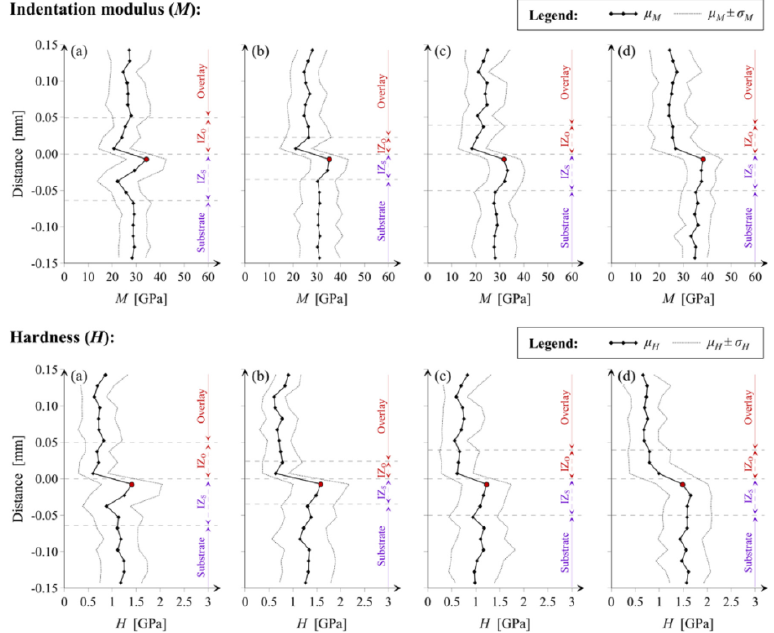
Figure 14. Exemplary maps of indentation modulus ( M ) and hardness ( H ) within the interface be ‐ tween cement mortar and concrete substrate [73]. (Adapted and reprinted with permission from ref. 73, © 2019, Construction and Building Materials